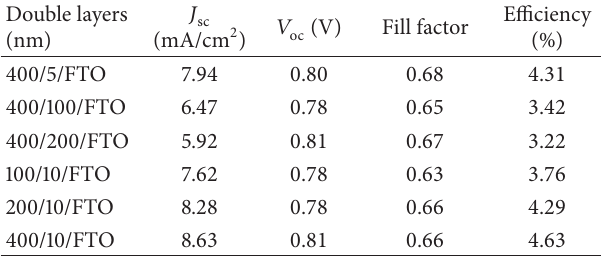
Table 2: Solar performance parameters of DSSCs with double-layer particlesizesinthebottomandtoplayers. structureofdifferentTiO 2